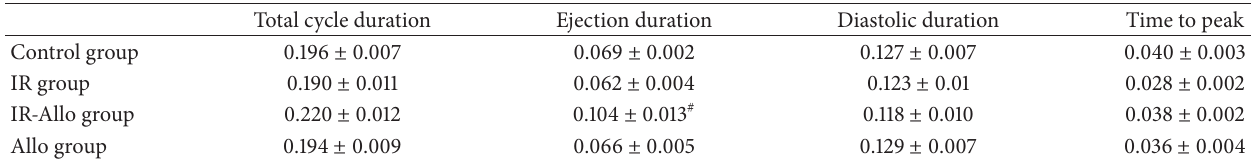
Table 3: The effect of allopurinol (Allo) treatment on insulin resistance (IR) induced BP cycle duration changes measured in seconds compared to control group.